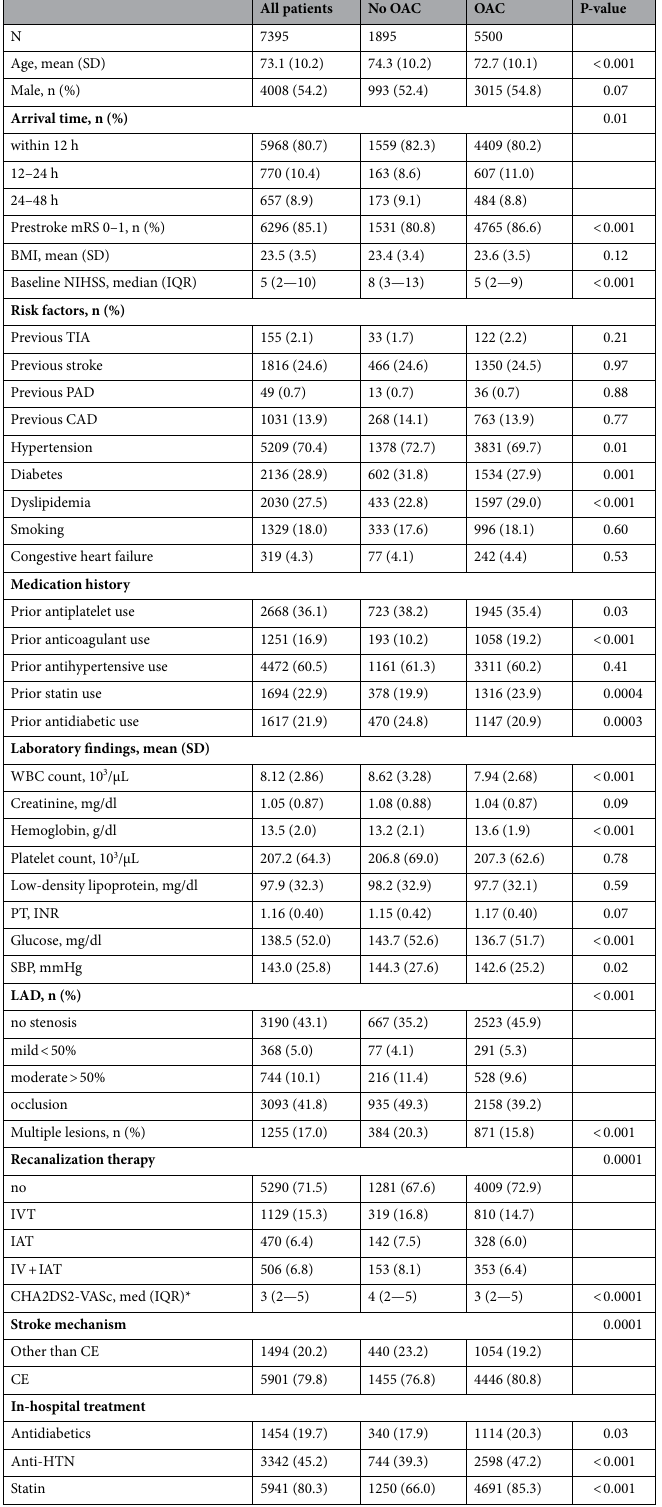
Table 1. General characteristics of subjects. OAC, oral anticoagulant; mRS, modified Rankin Scale; BMI, body mass index; NIHSS, National Institutes of Health Stroke Scale; TIA, transient ischemic attack; PAD, peripheral arterial disease; CAD, coronary artery disease; WBC, white blood cell count; PT, prothrombin time; LAD, large artery disease; IVT, intravenous thrombolysis; IAT, intra-arterial therapy; CE, cardioembolism; HTN,